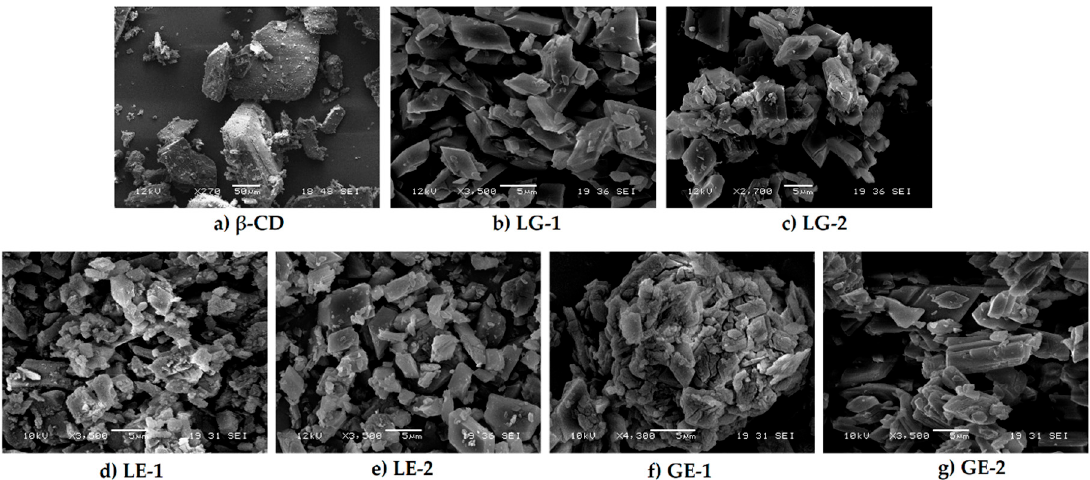
Figure 11. SEM images of ( a ) β -cyclodextrin ( β -CD); β -CD inclusion complexes with lemongrass oil ( b ) LG-1 and ( c ) LG-2; inclusion complexes with lemon eucalyptus oil ( d ) LE-1 and ( e ) LE-2; inclusion complexes with geranium Egyptian oil ( f ) GE-1 and ( g ) GE-2.